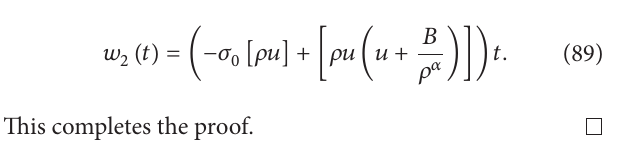
Figure 6: Numerical results for 𝑅 + 𝐽